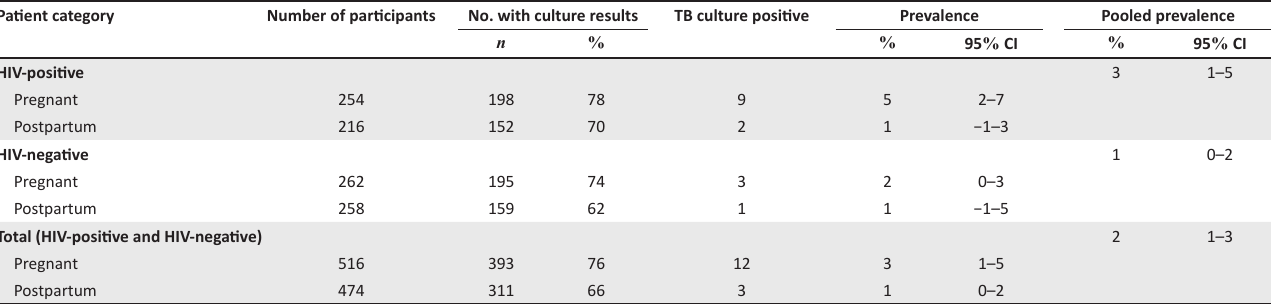
TABLE 2: Prevalence of tuberculosis, by HIV status, among pregnant and postpartum women attending antenatal and postnatal care clinics in Eswatini between April and November 2015. Patient category